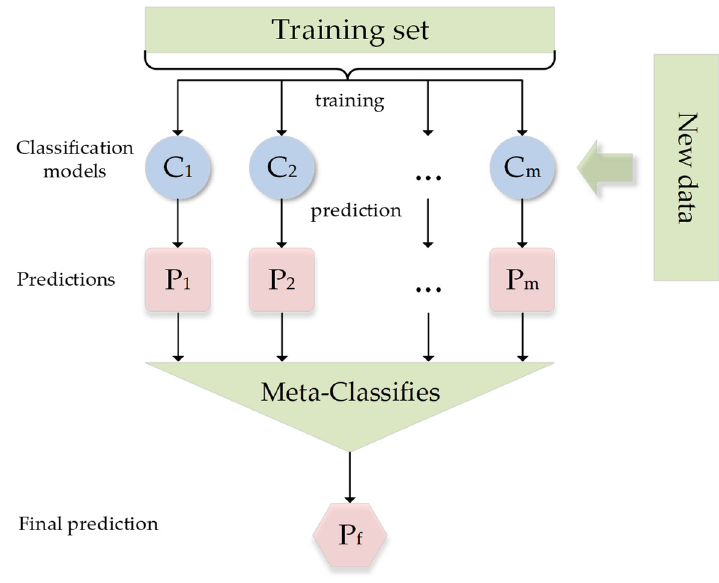
Figure 3. Schematic diagram of the hybrid model.